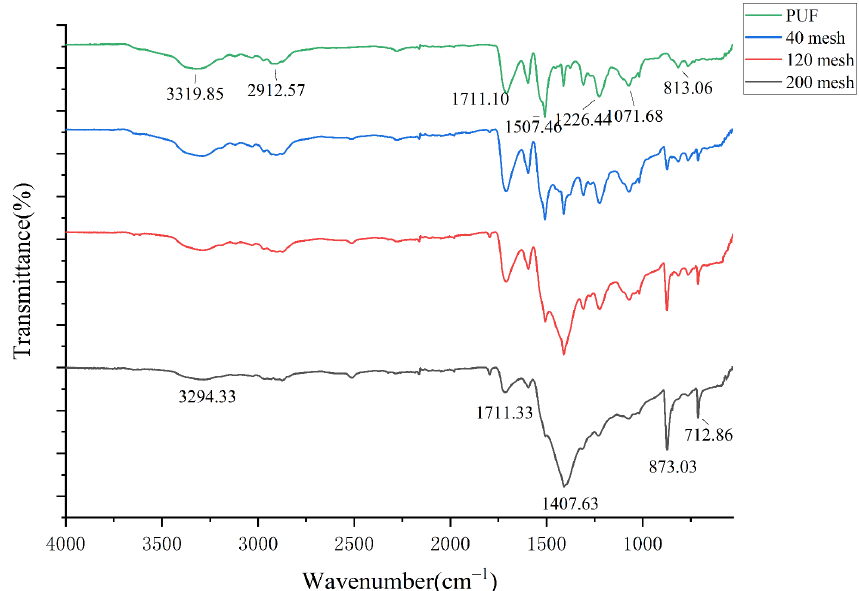
Figure 5. Fourier infrared spectra of polyurethane powders with different mesh numbers.